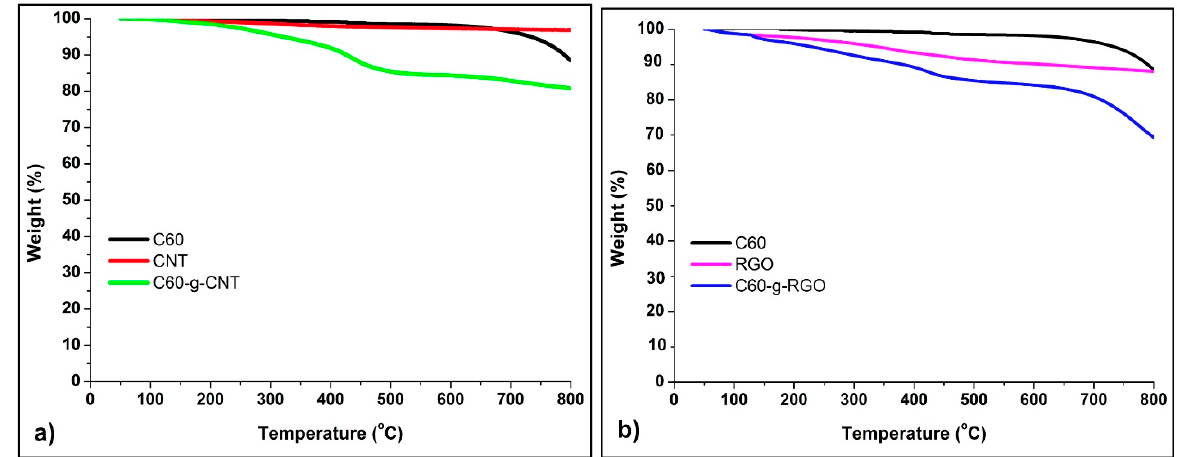
Figure 4. Compared thermogravimetric analysis curves of ( a ) C 60 , rGO and C 60 -g-rGO, ( b ) C 60 , CNT and C 60 -g-CNT nano- hybrids.